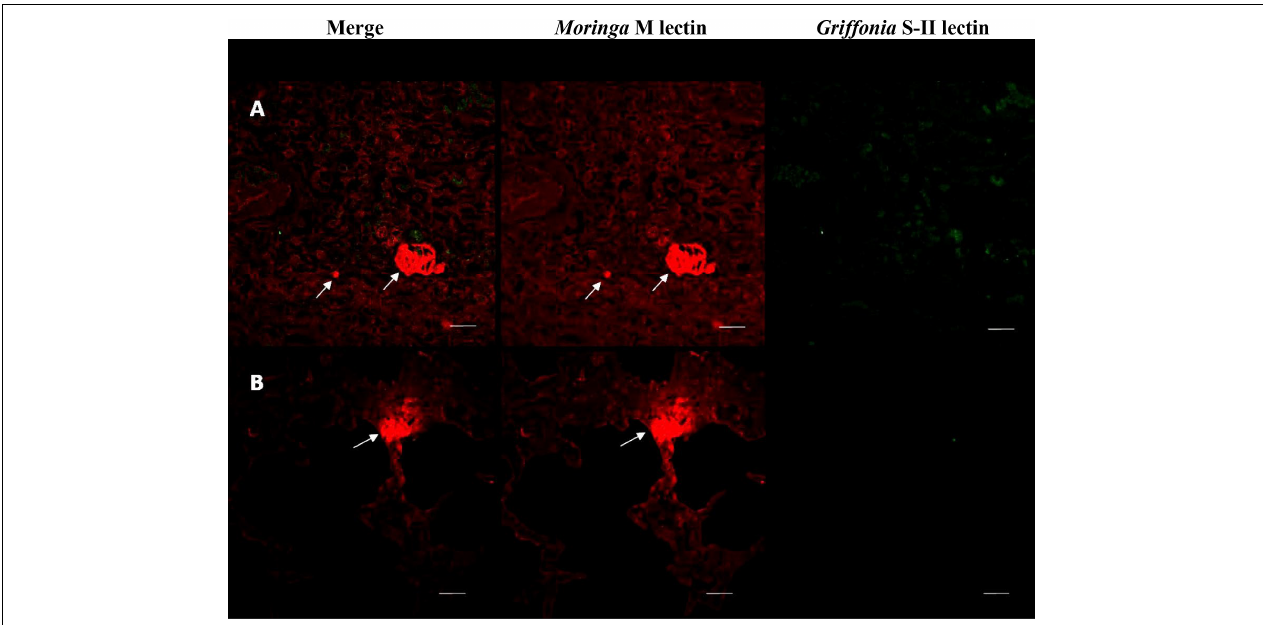
FIGURE 7 | Fluorescently tagged lectin staining of in vivo biofilm EPS. Lung tissue sections from calf 65 stained with fluorescently tagged lectins. (A,B) Two separate samples showing merged images of images using each lectin, section stained with Moringa M lectin labeled with TRITC for EPS from H. somni only, section stained with Griffonia simplicifolia labeled with FITC for EPS from P. multocida only. The H. somni EPS is only made during biofilm formation indicating the presence of a biofilm in these sections. Scale bar is equal to 20